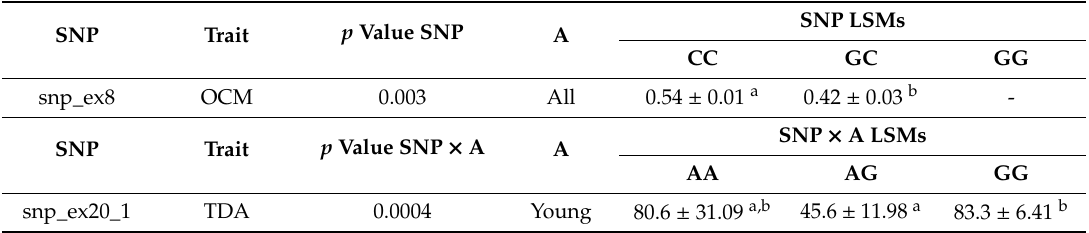
Table 3. Type III test for the significant SNPs and SNP by age (A) e ff ects on the LEPR gene using the seasonal traits from Rasa Aragonesa ewes. The least square means (LSMs) and standard errors for the SNP and the SNP x A e ff ects on the LEPR gene are also shown. Only significant SNPs after Bonferroni correction are shown. Di ff erent letters indicate significant di ff erences: a,b : p < 0.05. SNP LSMs SNP Trait p Value SNP A CC GC